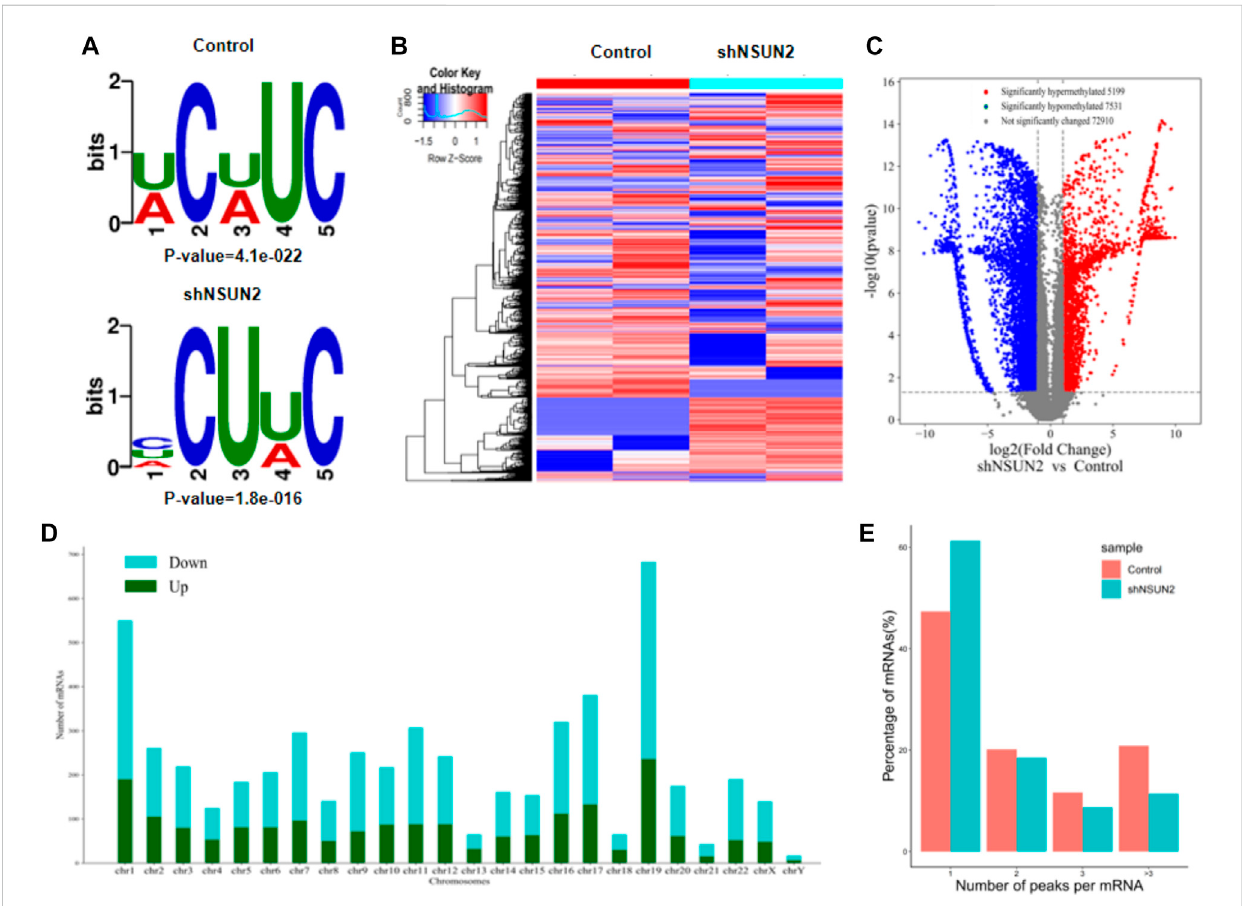
FIGURE 3 Characteristics of altered m5C peaks in HCT15 cell and sh-NSUN2 HCT15 cell (A) The sequence motif of m5C sites in HCT15 cell and sh-NSUN2 HCT15cell (B) ClusteranalysisofmethylationinHCT15cellandsh-NSUN2HCT15cell. (C) Volcanoplotsshowingthesigni fi cantlydifferentialm5Cpeaks. (D) The distributions of altered m5C peaks in human chromosomes. (E) The number of m5C peaks in HCT15 cell and sh-NSUN2 HCT15 cell on each mRNA. Most mRNAs have only one methylation peak.